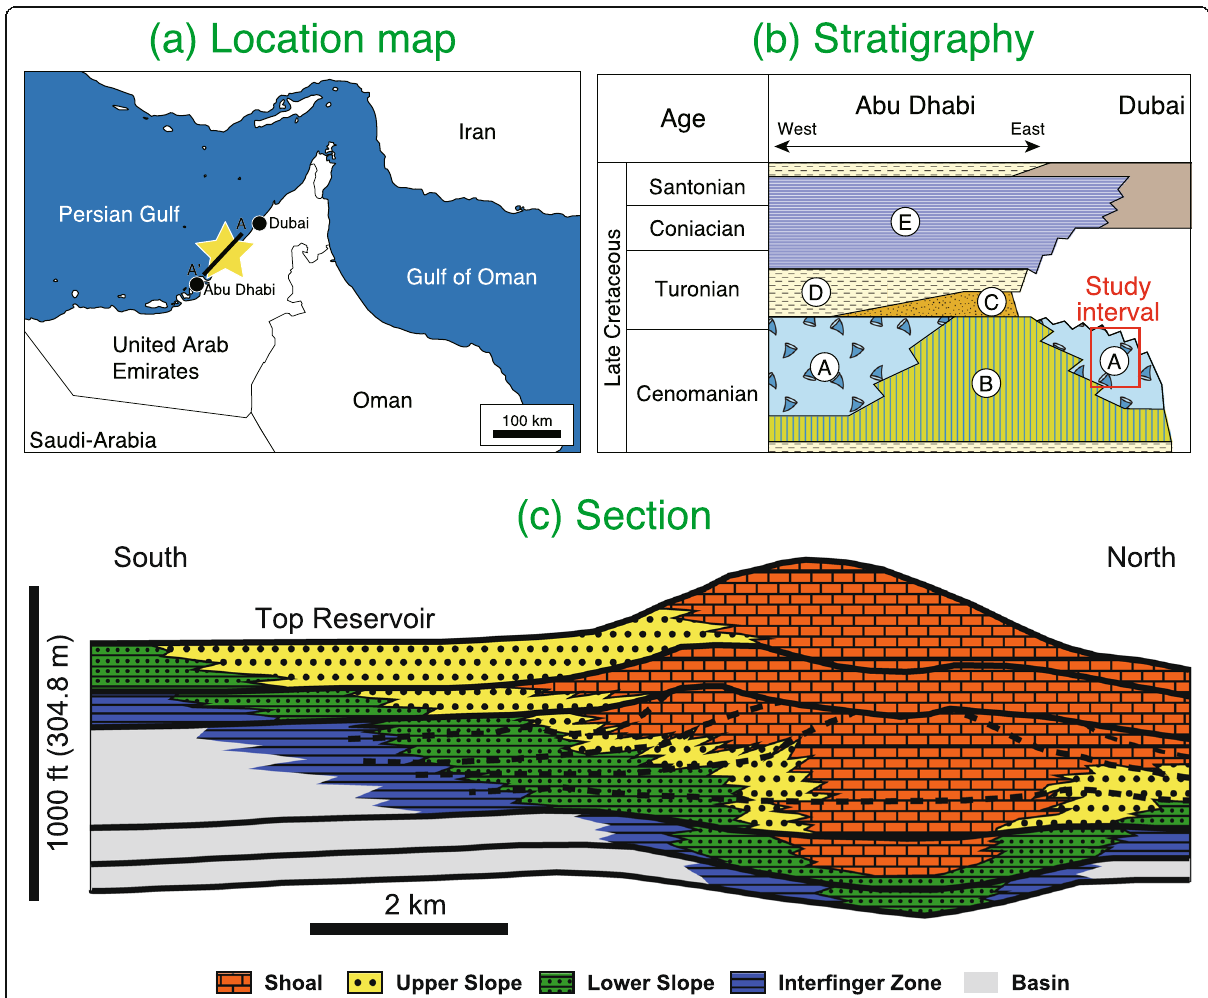
Fig. 1 Location, schematic cross-section, and lithostratigraphy of the “ A field ” . a Location of the A field, indicated by a yellow star. b Stratigraphic outline of the Upper Cretaceous succession in the Abu Dhabi to Dubai area (modified from Al-Zaabi et al. 2010 and Yamamoto et al. 2016). The stratigraphic interval examined in this study is indicated (red square). A, rudist-bearing porous limestone facies comprising mainly rudist-bearing rudstone and floatstone with a matrix of grainstone – packstone – wackestone; B, organic-rich dark-gray mudstone – wackestone – mudstone, partially stylolitized; C, siliciclastic sediments extensively filling the remaining accommodation space in the preceding intrashelf basin; D, platform facies comprising argillaceous limestone in central and western Abu Dhabi; E, dark grayish-brown to black shale, locally interbedded with dense limestone. Note that the facies C, D, and E were not deposited in eastern Abu Dhabi, due to uplift of this area. c Schematic cross-section of the A field (orange color denotes limestone-shoal facies, yellow upper-slope facies, green lower-slope facies, and blue basinal facies). Diagram modified from Neo